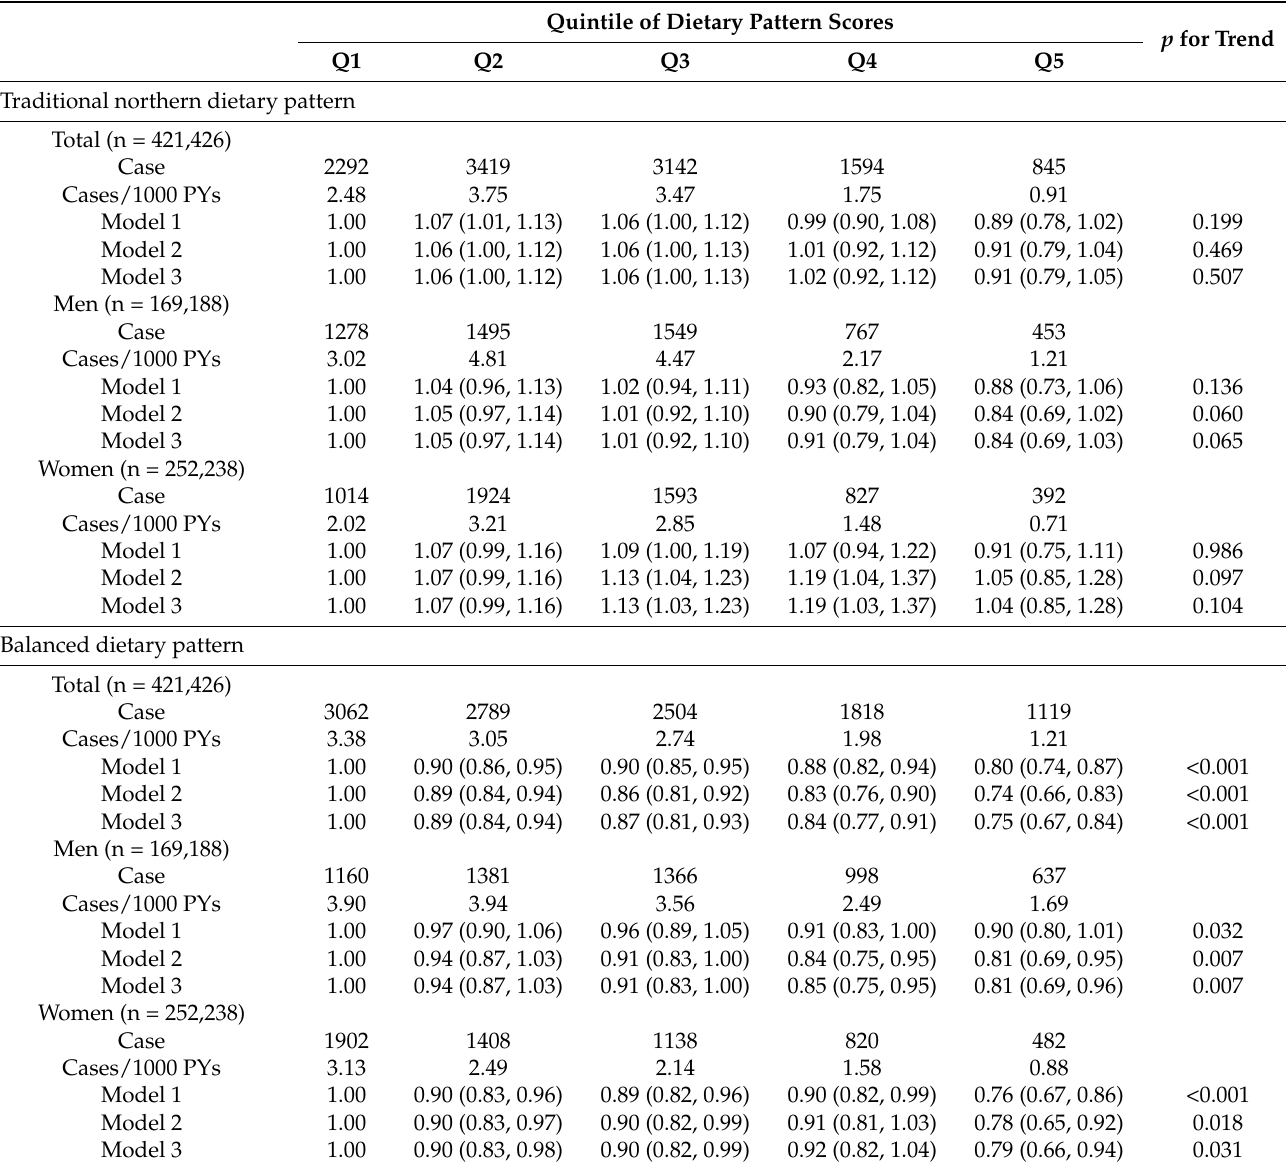
Table 3. HRs (95% CIs) for the association between dietary patterns and risk of COPD.